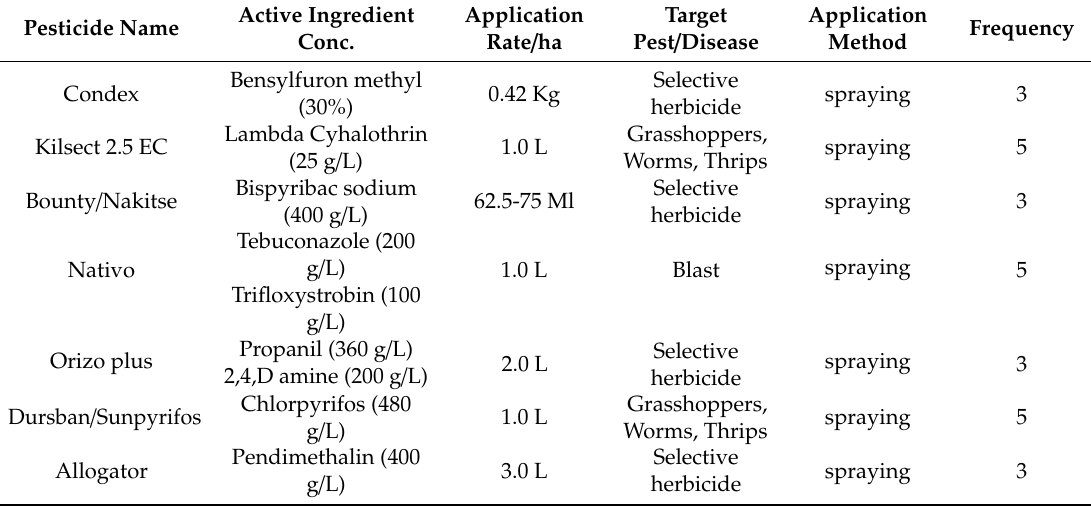
Table 1. The list of pesticides, application rate per hectare, active ingredients, and formulations used on the irrigation field under